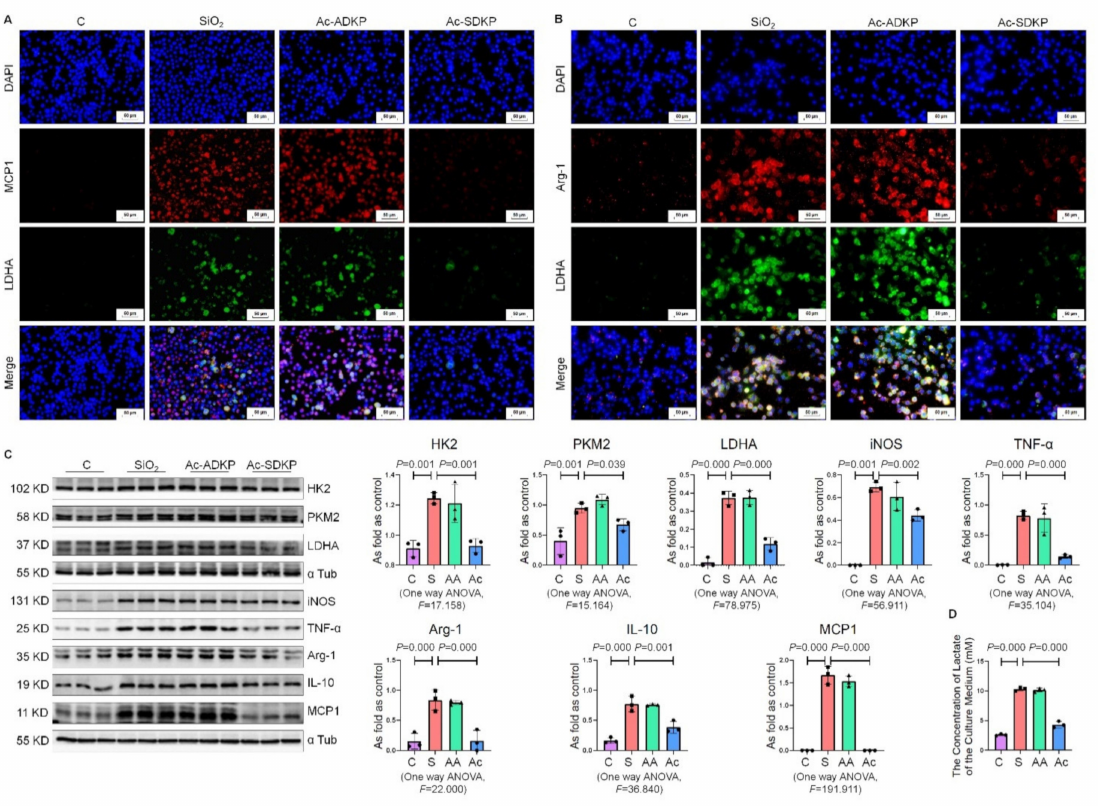
Figure 5. Ac-SDKP attenuates the enhancement of glycolysis in macrophages treated with silica. ( A ) The co-expression of MCP1 and LDHA in NR8383 cells was measured by IF staining, bar= 50 µ m; ( B ) The co-expression of Arg-1 and LDHA in NR8383 cells was measured by IF staining, bar= 50 µ m. ( C ) Protein expression of HK2, PKM2, LDHA, iNOS, TNF- α , Arg-1, IL-10, and MCP1 in NR8383 cells treated with or without SiO 2 , Ac-ADKP, and Ac-SDKP. Data are presented as the mean ± SD. n = 3 per group. ( D ) The lactate content in the culture medium was detected using a lactate assay kit. C: control; S: SiO 2 ; AA: Ac-ADKP: SiO 2 and Ac-ADKP; Ac: Ac-SDKP: SiO 2 and